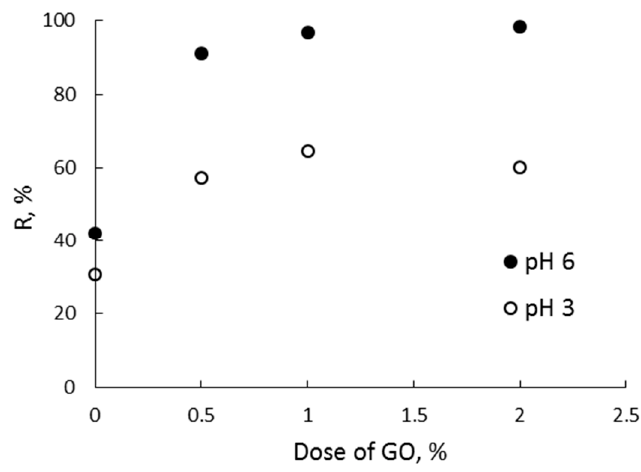
Figure 2. Removal e ffi ciency of Zn (II) by the synthetized Figure 2. Removal efficiency of Zn (II) by the synthetized sorbents.